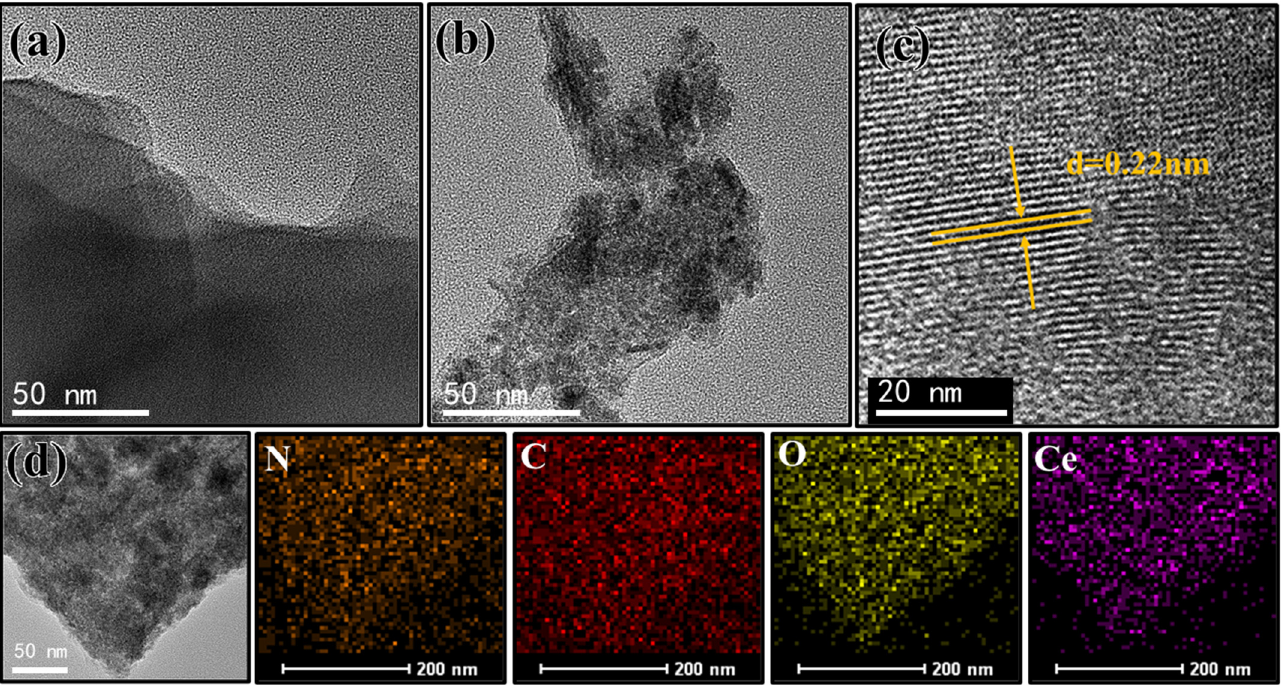
Figure 3. ( a , b ) TEM images of ( c ) HRTEM images and ( d ) energy dispersive x-ray energy spectrum mapping of Ce(IV)/PEI-C/PAA-GO.